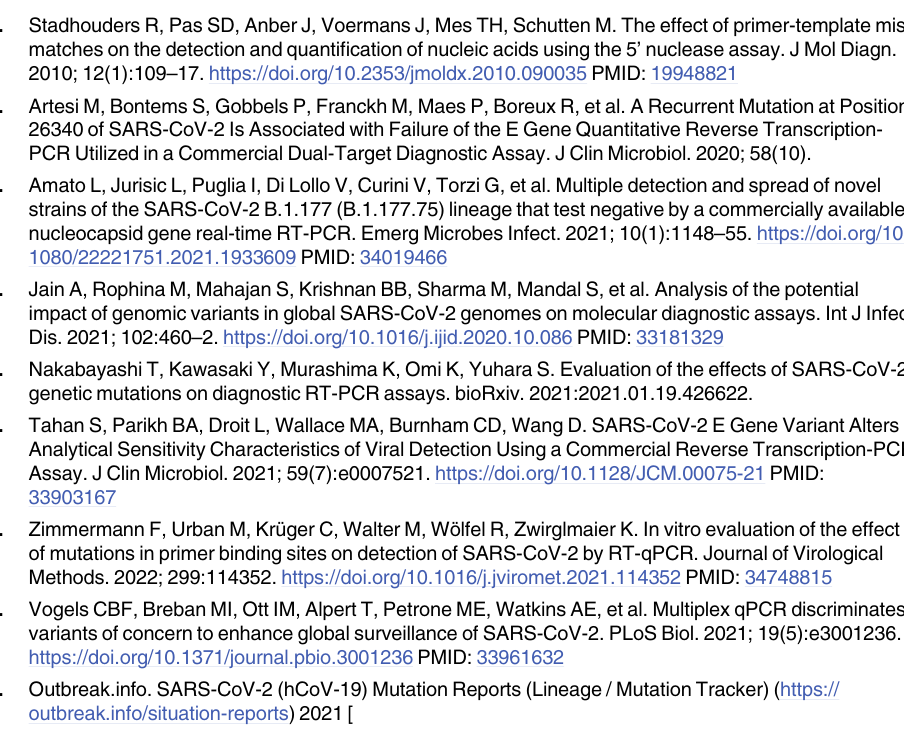
S3 Fig. Discrimination of SGF deletion with mismatched primers. (A) Comparison of sequences of the 5’ of the FIP primers for detecting wt or SGF deletion. (B) LAMP amplifica- tion with primer set containing SGFdel-FIP. 8x repeats of LAMP reactions were performed with 1000 or 10 copies of RNA from B117 or wt. The speed of LAMP is shown as “# of Cq” with each Cq equal to 24s. Positive amplification threshold is Cq <